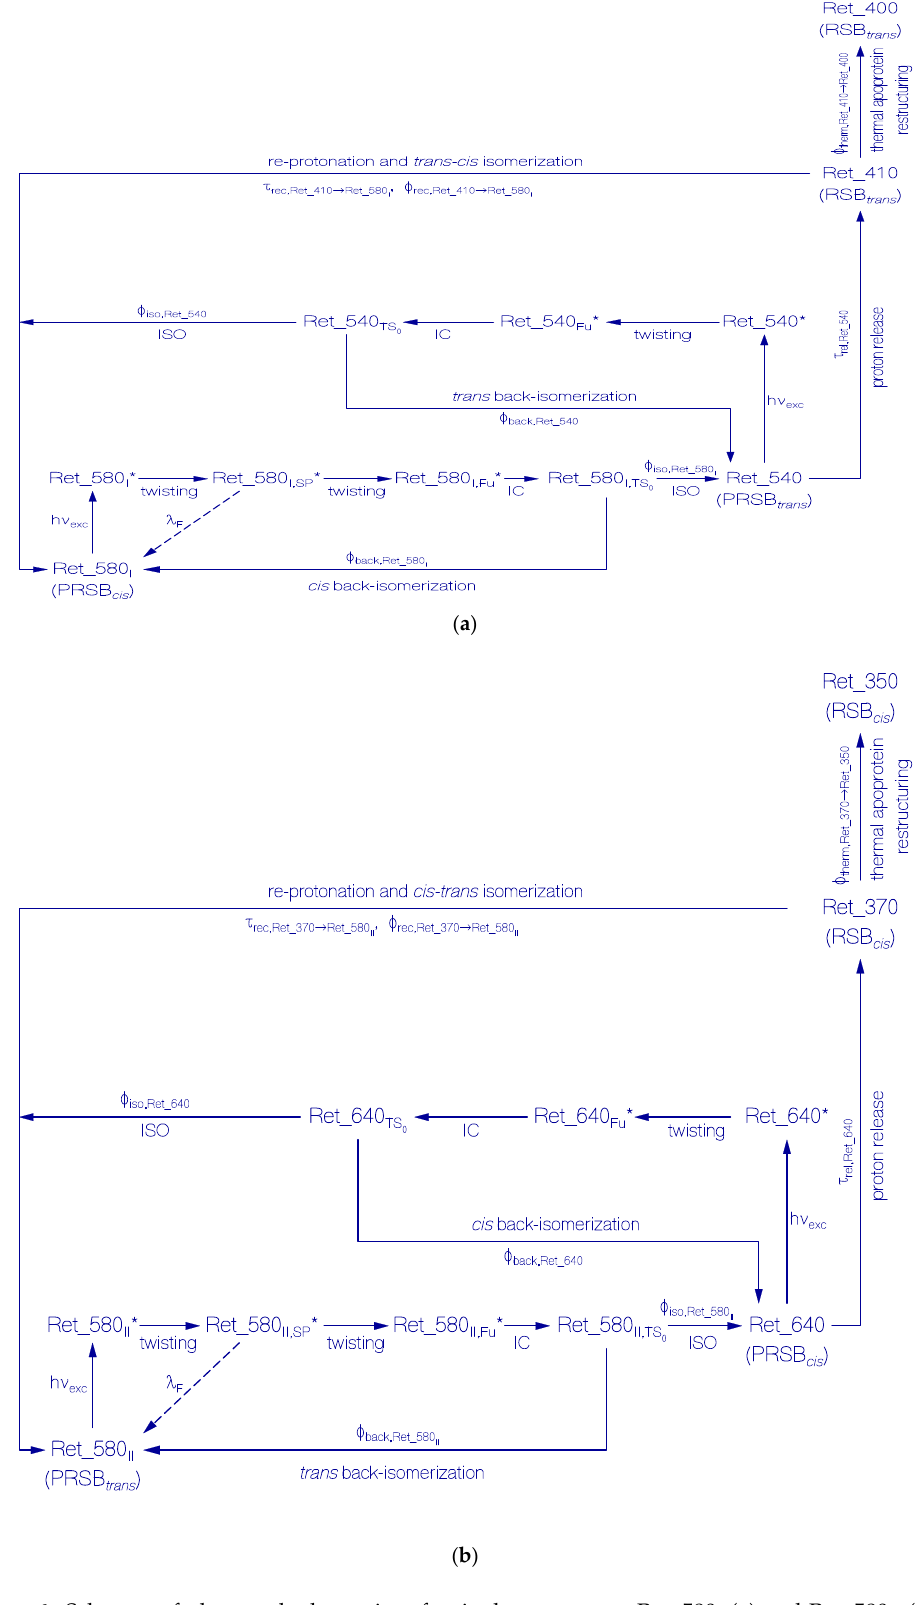
Figure 6. Schemes of photocycle dynamics of retinal components Ret_580 I ( a ) and Ret_580 II ( b ) of QuasAr1 in pH 8 Tris buffer. IC, internal conversion and ISO, isomerization.